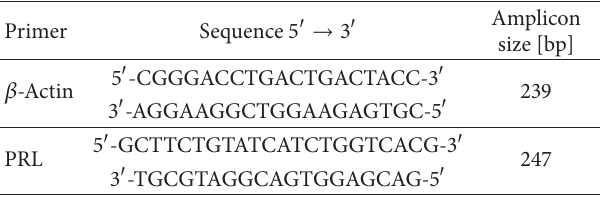
Table 1: PCR primers for 𝛽 -actin and PRL and their amplicon size.